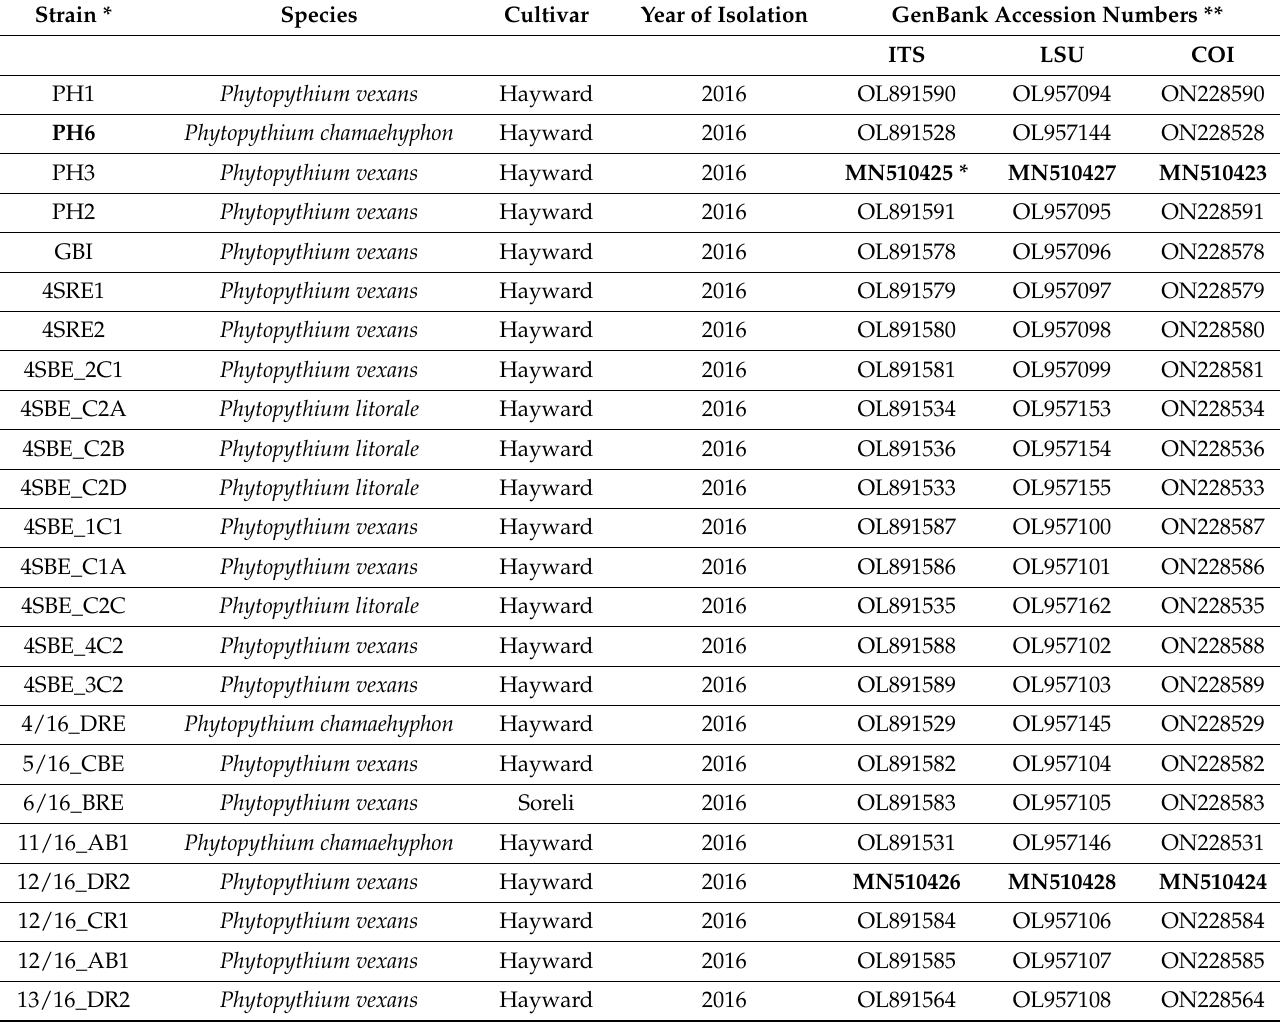
Table S2. All sequences were deposited in GenBank (Table 1). Table 1. Strain name, molecular identification, cultivar, year of isolation and GenBank accession numbers of the Phytopythium spp. strains isolated from kiwifruit roots in this